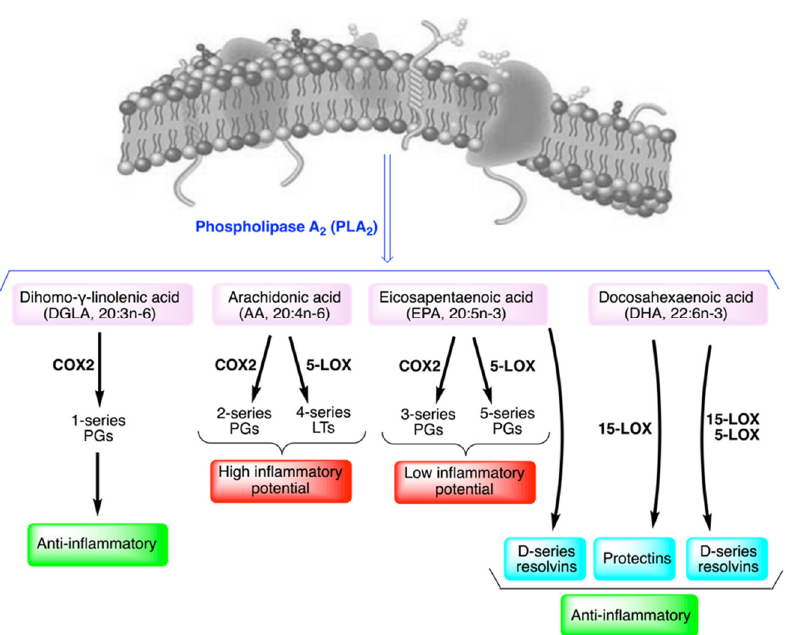
Figure 3. The balance among omega-6 and omega-3 fatty acids in membranes for the generation of signaling molecules upon release from membrane phospholipids.